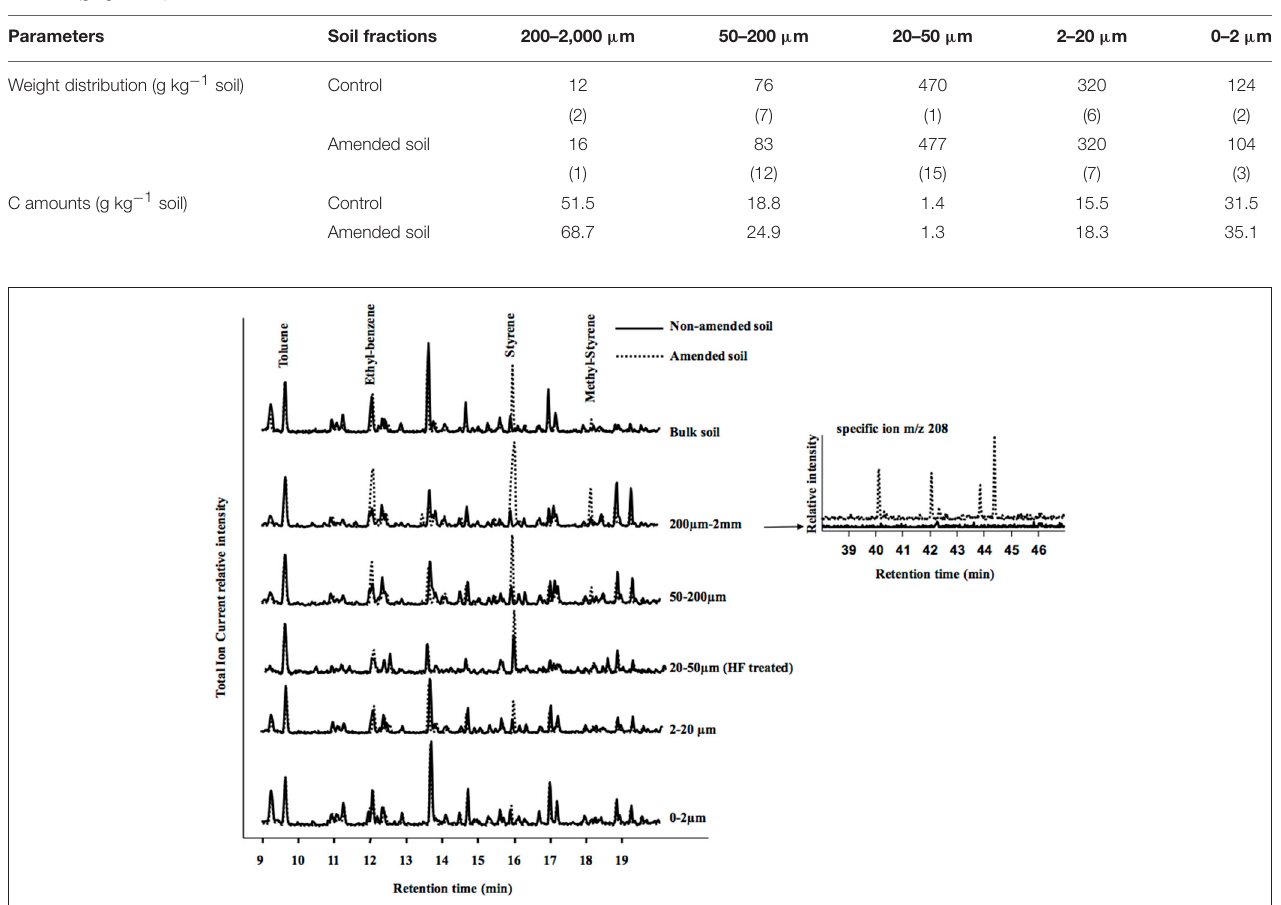
FIGURE 5 | On the left: total Ion Current (TIC) traces of pyrograms in the 9–20min region showing toluene, styrene and methyl styrene peaks for control and amended soil samples (bulk soil) and their particle size fractions. Pyrograms are presented with the toluene peak at the same height for easier graphical comparison. Fractions 20–50 µ m were analyzed after HF treatment. On the right: traces of the ion m/z 208, specific for styrene dimers and trimers (according to Dignac et al., 2005), peaks only detected in the 200 µ m − 2mm fractions of the amended soil (compared to the control).